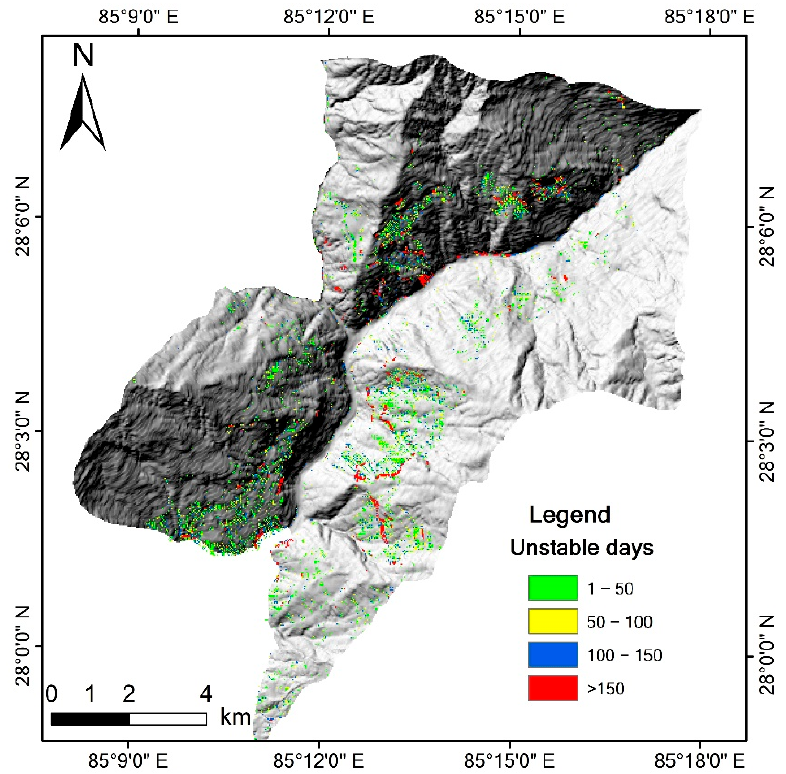
Figure 7. Number of unstable days.